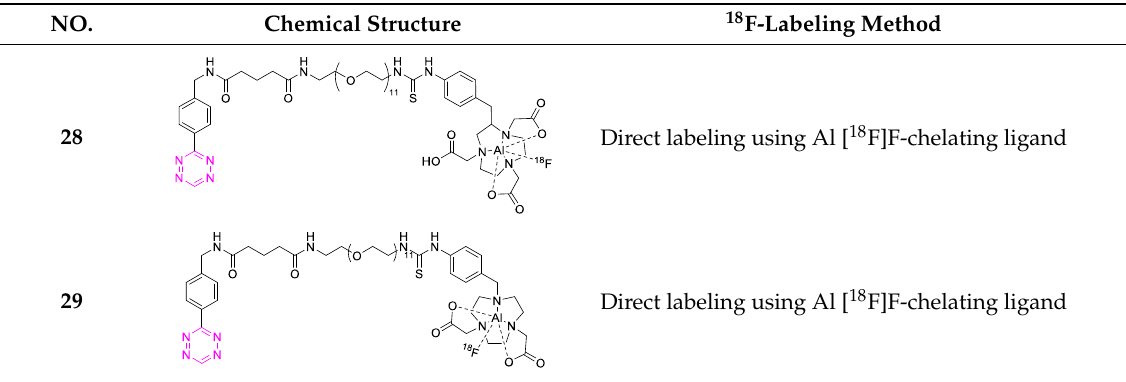
Table 5. List of aluminum [ 18 F]fluoride labeled Tz.